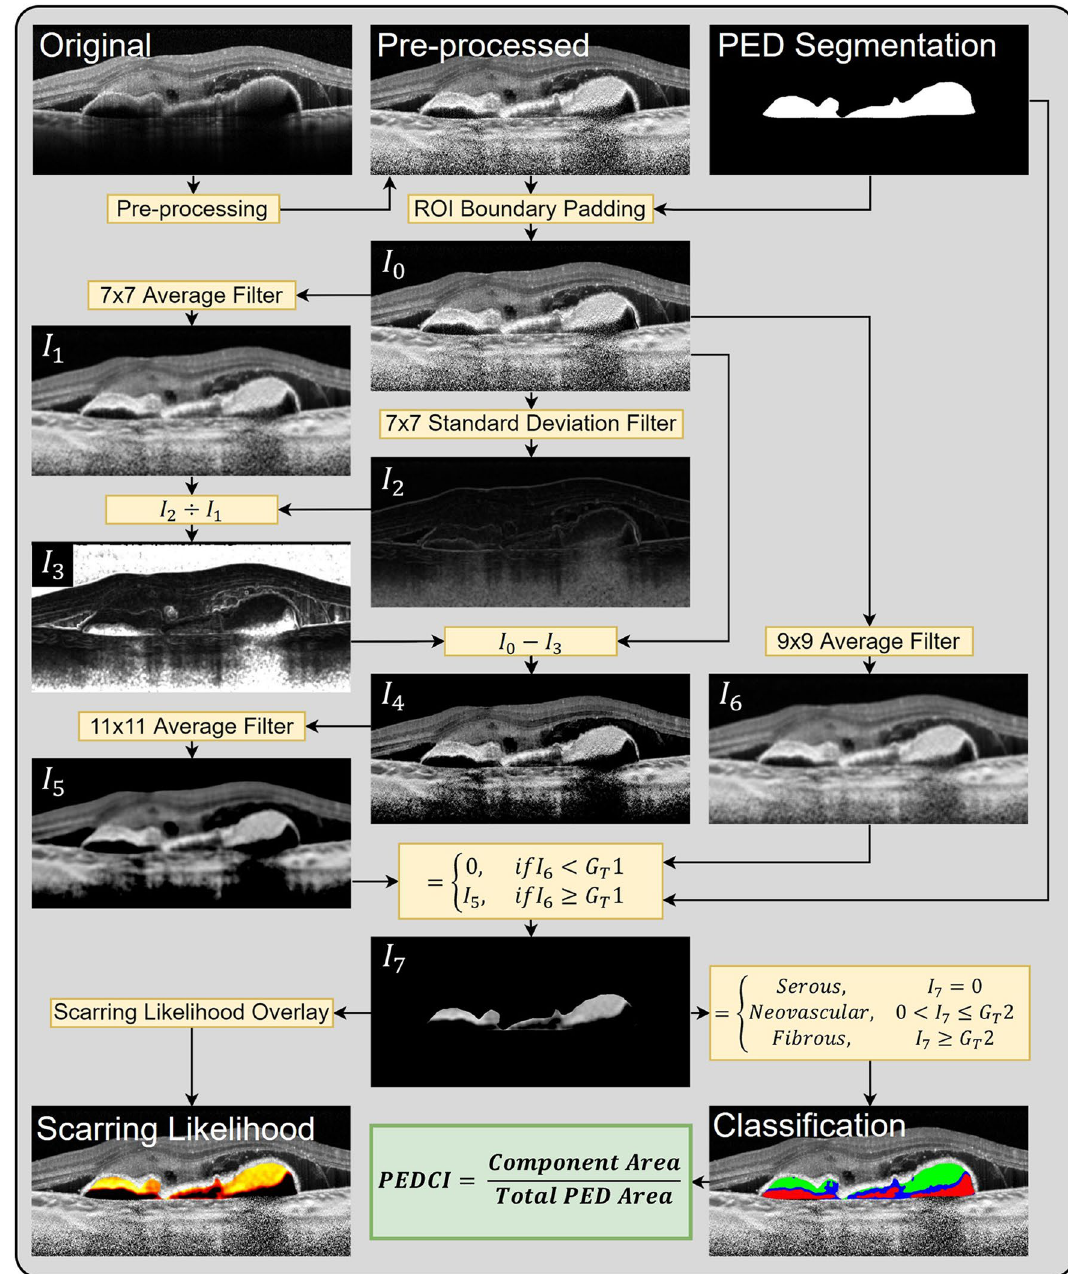
Figure 1. Proposed methodology for classification of serous, neovascular, and fibrous tissues in pigment epithelial detachments (PED) and derivation of PED composition indices (PEDCI). Starting with the original B-scan image in the top left, pre-processing steps including linear normalization and shadow compensation were applied. The segmented PED was subsequently used to pad the region of interest in the processed image, I 0 . The transformation between I 0 to I 7 involves a series of kernel-based filtering steps. Classification of components within the PED was performed using I 7 . PEDCI-S was derived from the ratio of the serous component area to total PED area, PEDCI-N was derived from the ratio of the neovascular component area to total PED area, and PEDCI-F was derived from the ratio of the fibrous component area to total PED